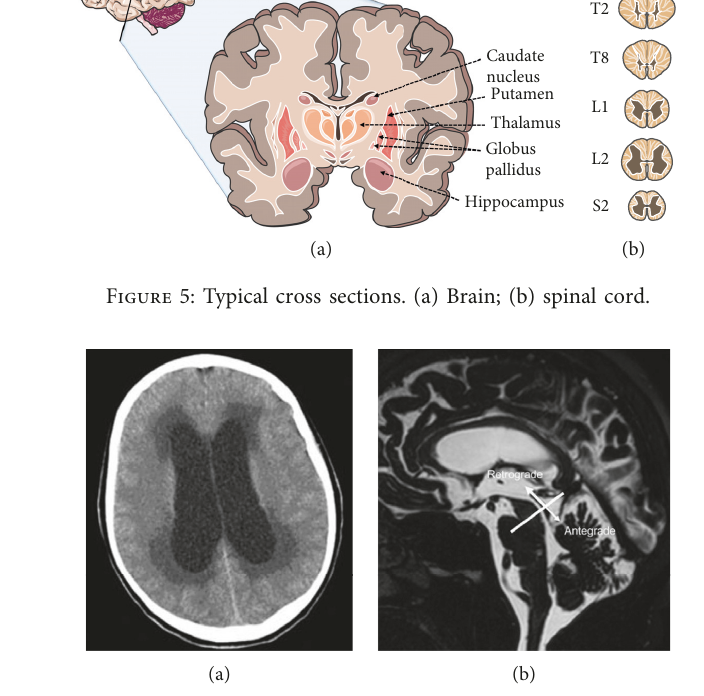
Figure 6: (a) Hydrocephaly image by CTscan (the image is obtained from Fitz and Harwood-Nash (1978)). (b) MRI obtained by steady-state technique (the image is obtained from Ringstad et al.